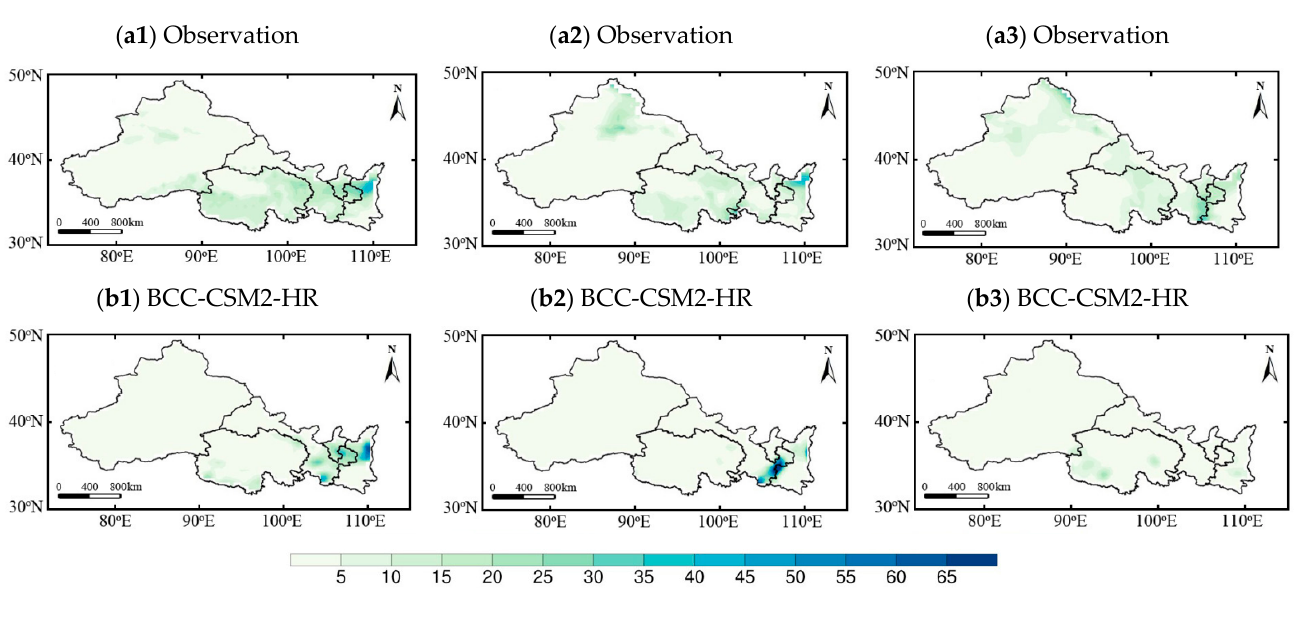
Figure 11. Distribution of extreme precipitation over Northwest China in Event 1 ( left ), Event 2 ( middle ), and Event 3 ( right ): observations and the values simulated by the BCC-CSM2-HR. Unit: mm.